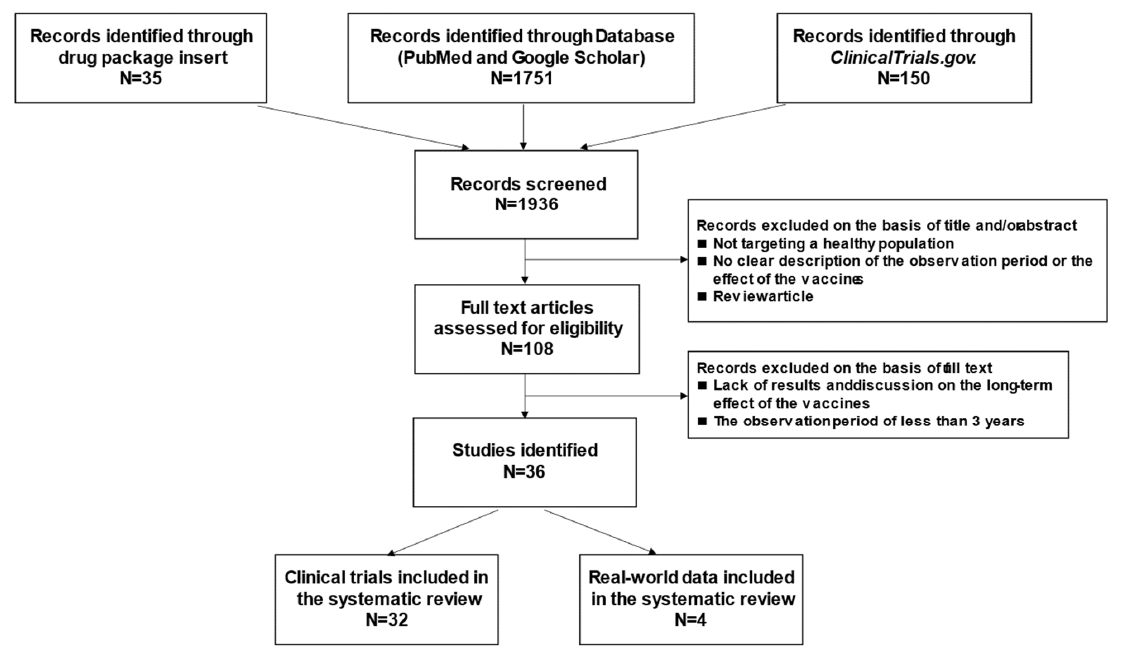
Figure 1. Flow-chart diagram of study selection. PubMed and Google Scholar literature searches